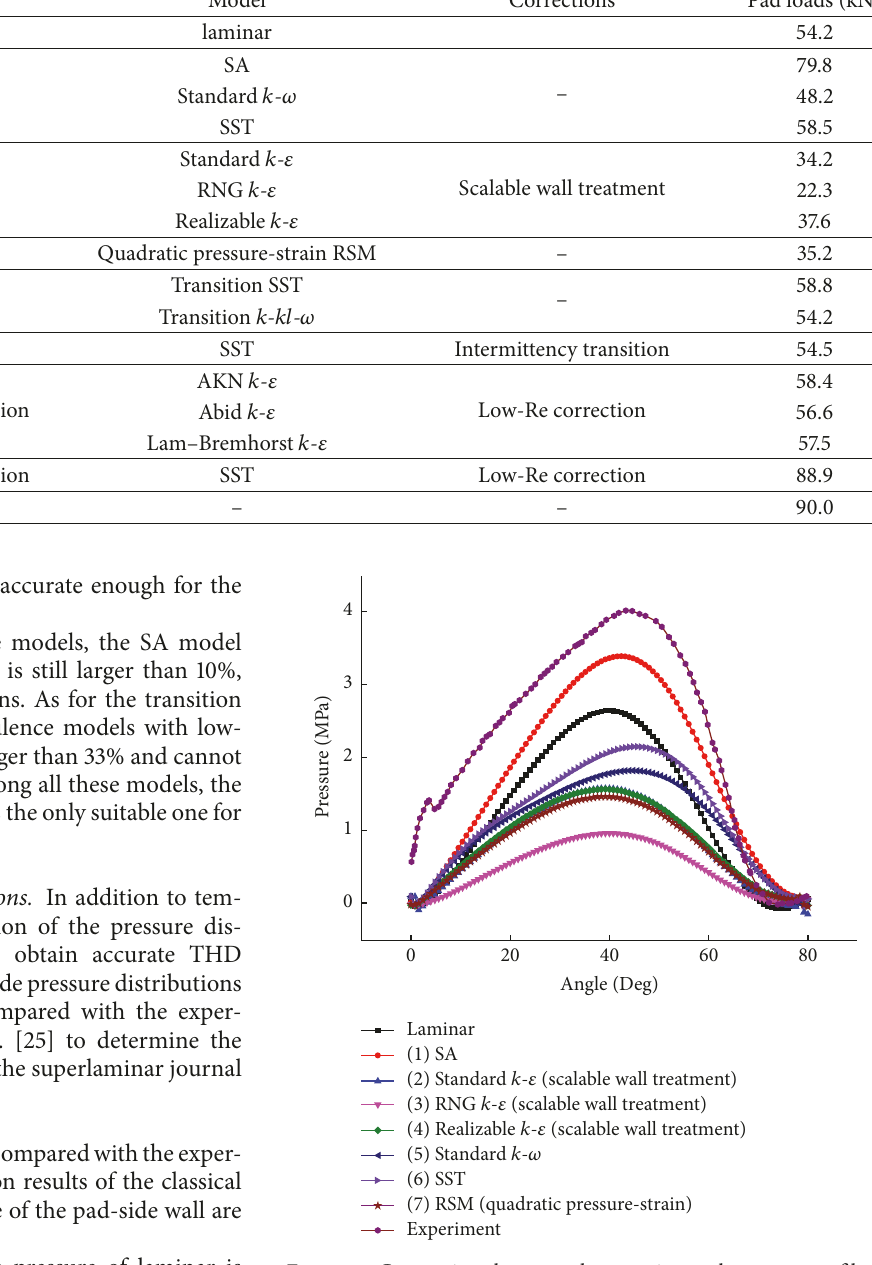
Figure 7: Comparison between the experimental pressure profile at 3000 rpm and under 180kN and the simulated pressure profiles with the fixed film geometry in pad-side center line for the group of the classical turbulence